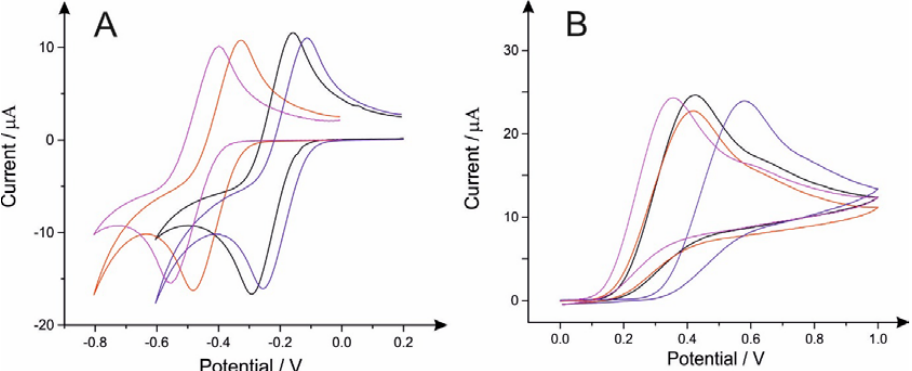
Figure S8. Typical cyclic voltammograms recorded using PDE1 (drawn 60 times) towards 1 mM hexaammineruthenium(III) chloride/0.1 M KCl ( A ) and 1 mM uric acid/0.1 M PBS ( B ), utilising screen-printed Ag/AgCl (black line), screen-printed carbon (red line), saturated calomel electrode (purple line) and pencil-drawn graphite references (pink line). Scan rate: 50 mV·s − 1 .